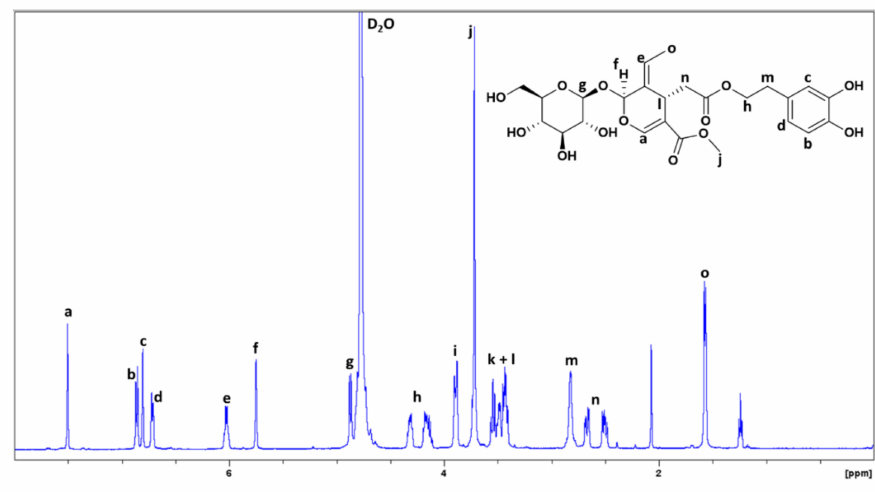
Figure 3. 1 H-NMR spectrum (500 MHz, D 2 O) of